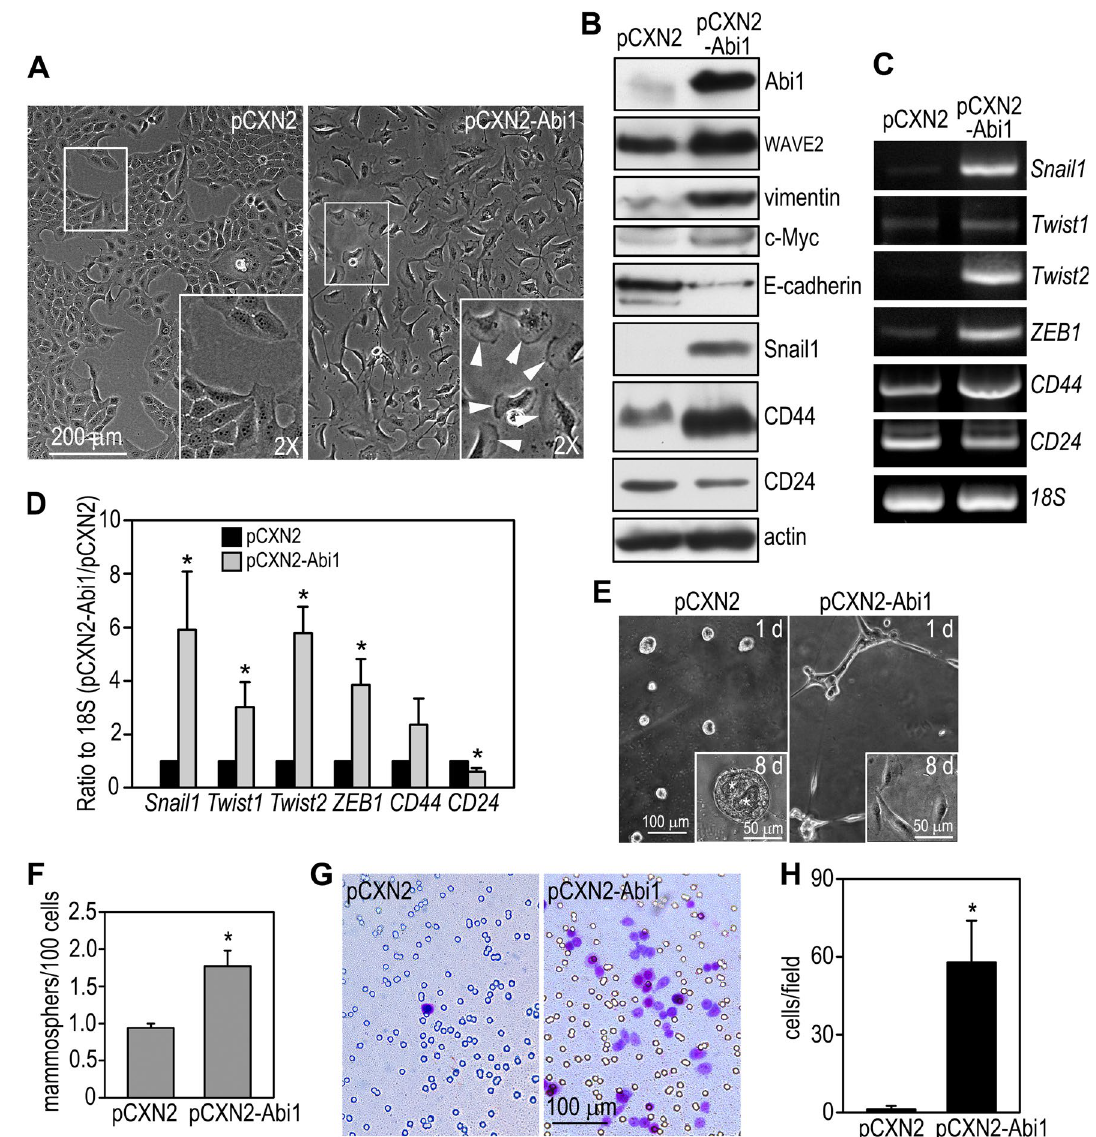
Figure 5. Overexpression of Abi1 in mammary epithelial cells induces the EMT and increases stem cell activity. ( A ) MCF10A human mammary epithelial cells were stably transfected with Abi1 (pCXN2-Abi1) or the vector alone (pCXN2). Live phase contrast micrographs show that overexpression of Abi1 converted MCF10A cells from an epithelial to a fibroblastic shape with prominent lamellipodia (arrowheads in the inset). ( B ) Control and Abi1-expressing MCF10A cells were subjected to immunoblot analysis. Actin served as a loading control. ( C ) RT-PCR showed that Abi1 overexpression increased the expression of EMT-inducing transcription factors and the ratio of CD44/CD24. ( D ) Ethidium bromide-stained gels were quantified by densitometry and plotted as a ratio to 18S. N = 3, * P < 0.05 vs cells transfected with pCXN2 only. ( E ) Live phase contrast micrographs show control and Abi1-overexpressing MCF10A cells cultured on Matrigel for 24 h and 8 days (insets). *Indicates cavity formation. ( F ) Abi1 overexpression increased mammosphere formation. N = 24, * P < 0.01. ( G ) Matrigel invasion assay showed increased cell migration to the bottom of the transwell after Abi1 overexpression. ( H ) Cells migrated to the bottom of the transwell were counted in 20 × field and plotted. N = 24, * P <